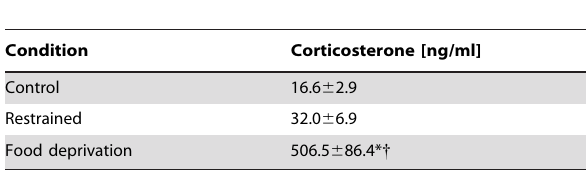
Table 2. Corticosterone levels in experiment